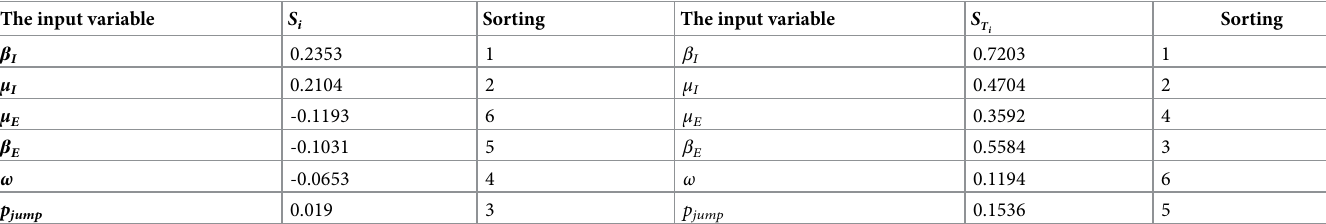
Table 3. Sensitivity index of each variable to ρ